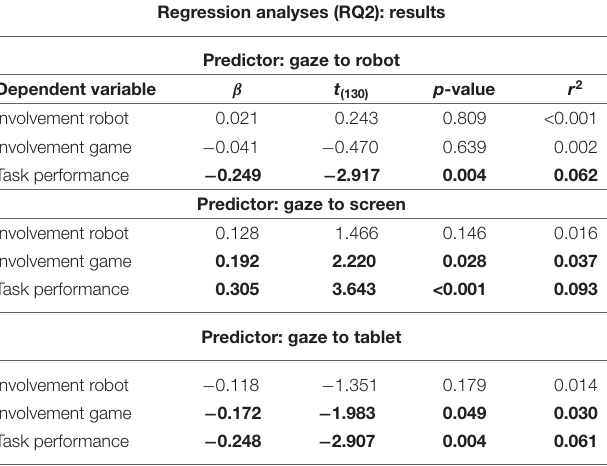
TABLE 7 | Results of the regression analyses performed for RQ2. Regression analyses (RQ2):